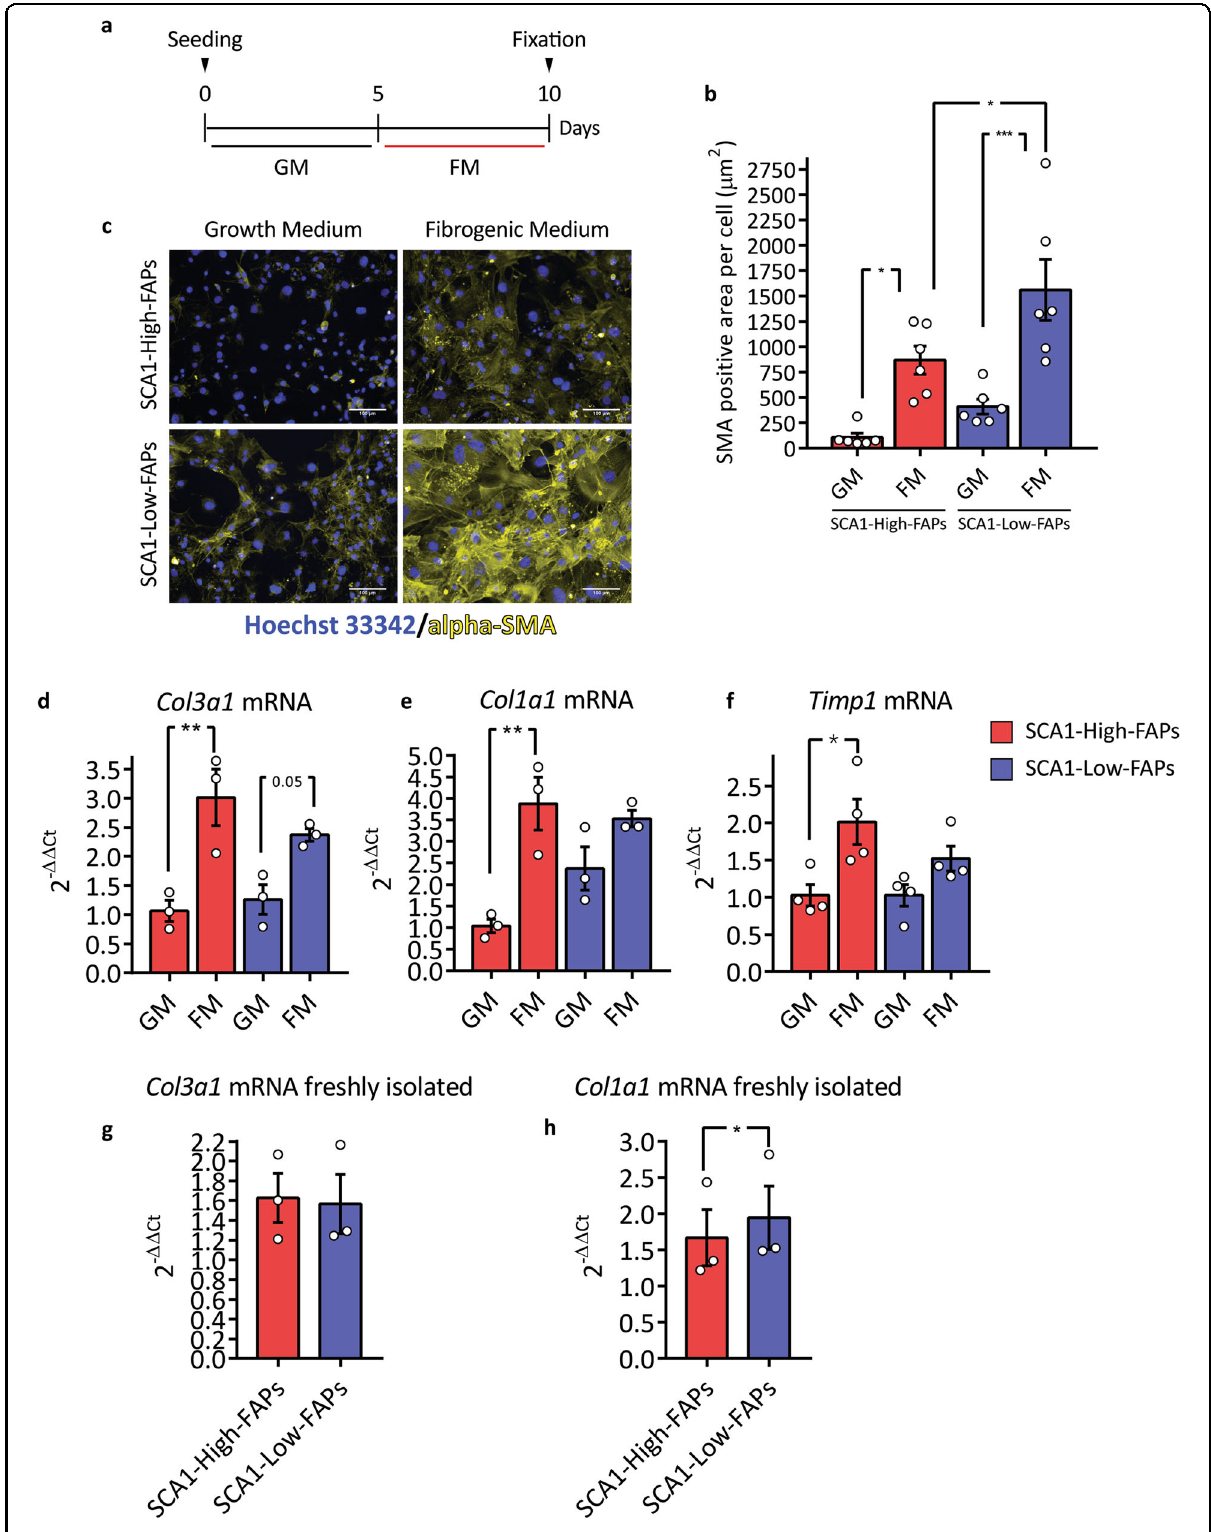
Fig. 4 (See legend on next